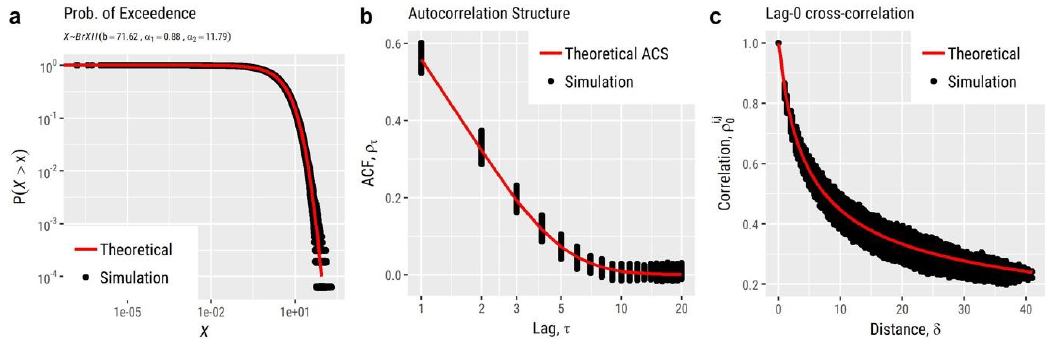
Figure 7. Comparison between RF’s target and simulated: ( a ) distribution function; ( b ) autocorrelation structure; and ( c ) lag-0 cross-correlation.